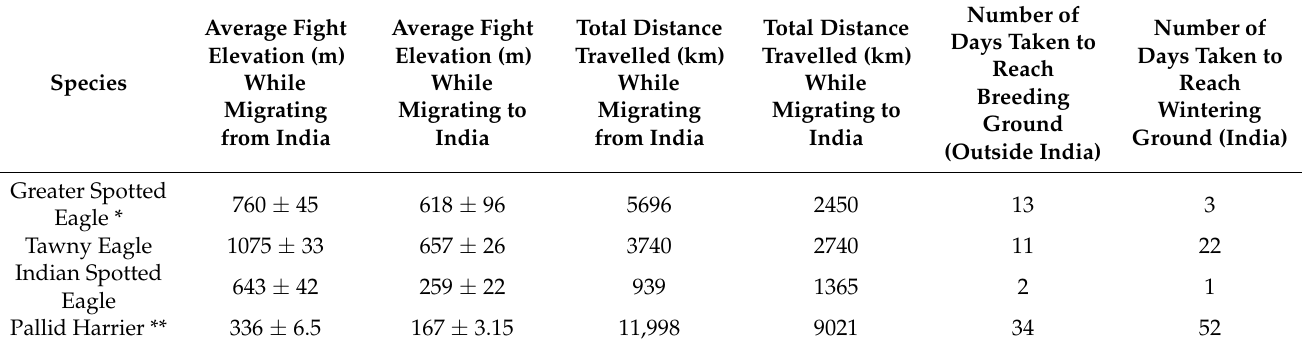
Table 6. Details of the distance travelled, number of days stayed, and average elevation used during migration from wintering grounds (India) to breeding grounds (outside India) by Greater Spotted Eagle, Tawny Eagle, Indian Spotted Eagle, and Pallid Harrier fitted with satellite transmitters.